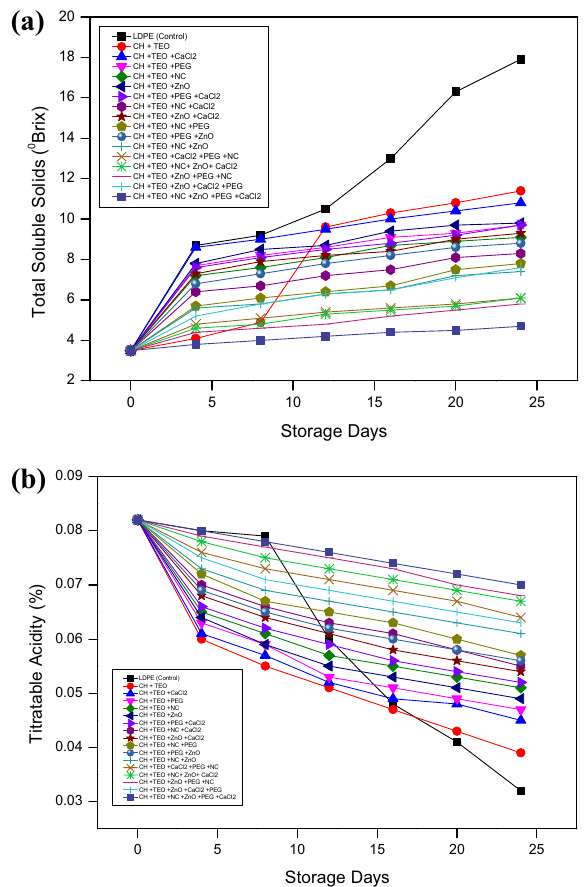
Figure 3. ( a ) Effect of different chitosan-based films and storage days on total soluble solids (°Brix) of collard greens. ( b) Effect of different chitosan-based films and storage days on titratable acidity (%) of collard